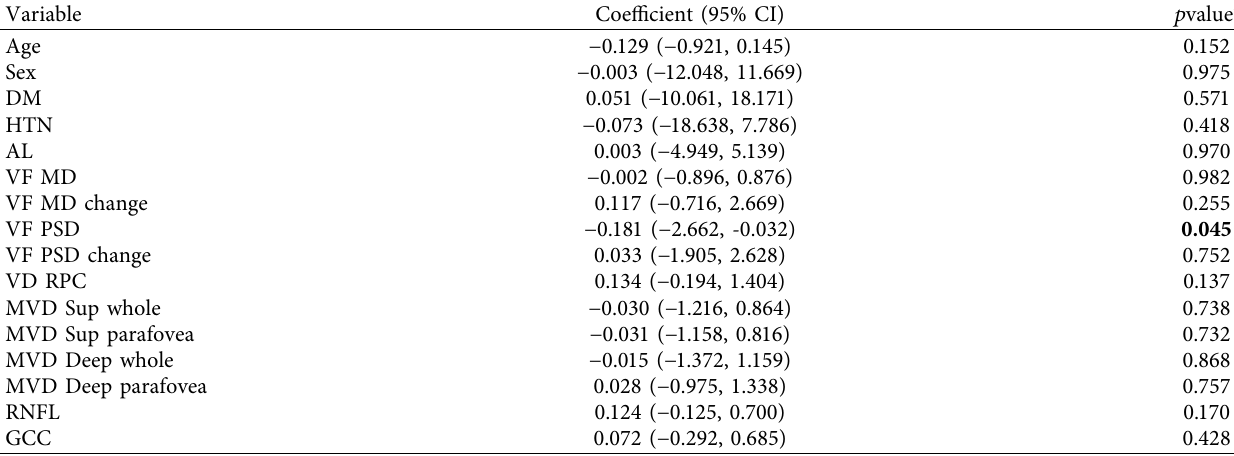
Table 3: Confounding factors associated with central corneal thickness in the NTG group evaluated via linear regression analysis. Variable